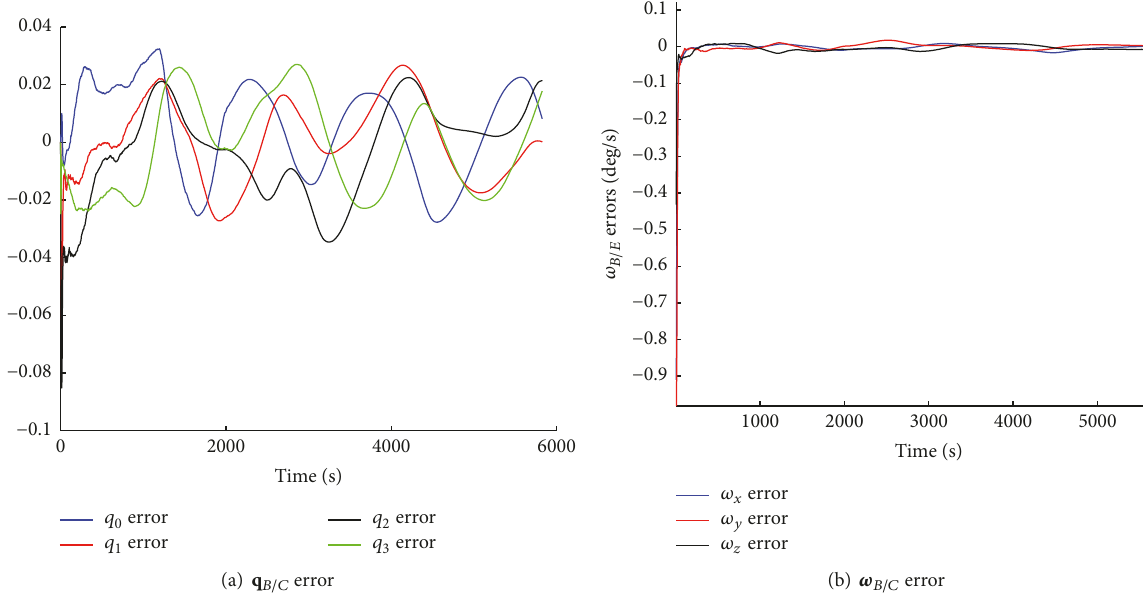
Figure 8: (a) Quaternions estimation errors in components: q 𝐵/𝐶 −̂ q 𝐵/𝐶 . (b) Target’s angular velocity estimation error in components: 𝜔 BDRF 𝐵/𝐸 − ̂ 𝜔 BDRF 𝐵/𝐸